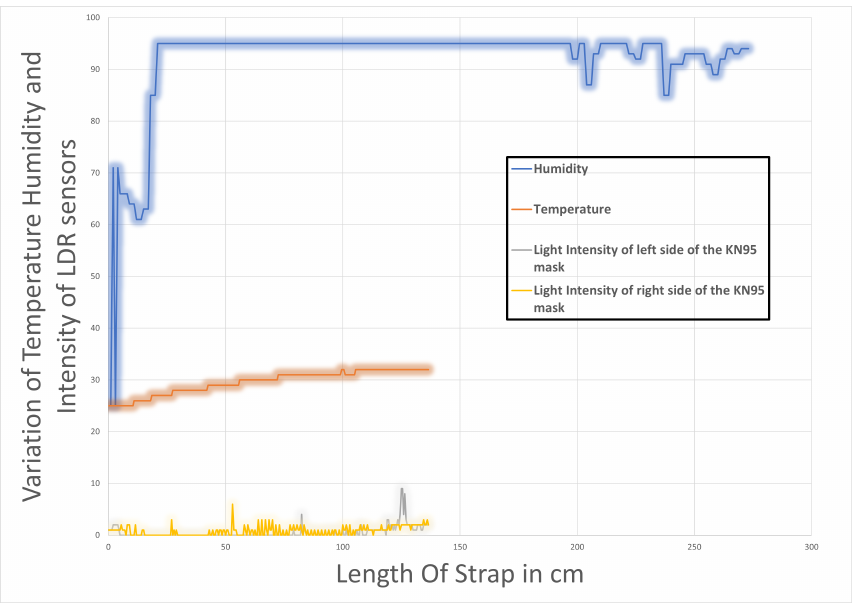
Figure 24. Data collected after the mask is worn for 2